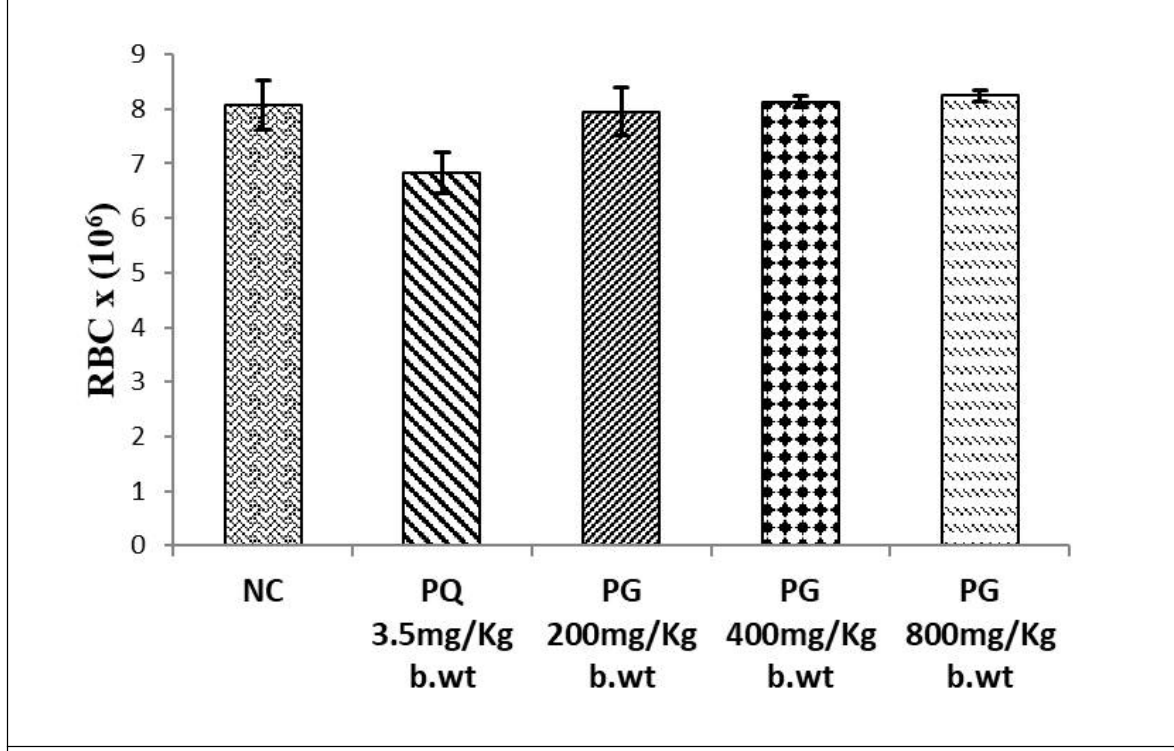
Figure 12: Effect of Psidium guajava leaf extract administration on red blood cells count of male Wistar albino rats administered 3.5 mg/kg b.wt. Paraquat